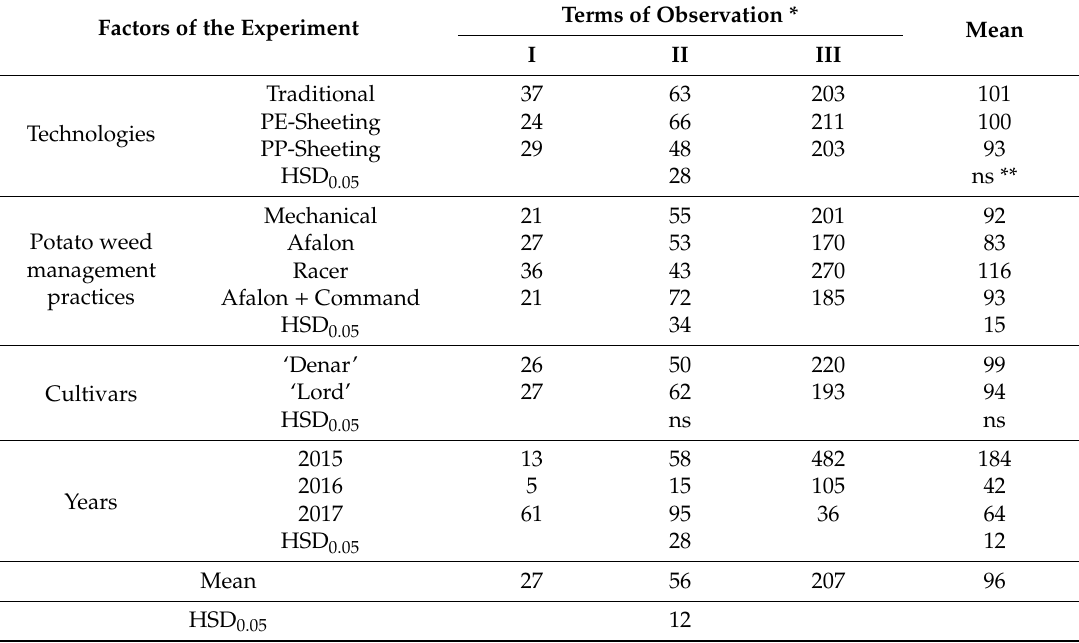
Table 7. Impact of technology, methods of weed management, cultivars, and years of cultivation on fresh weed mass (g m − 2